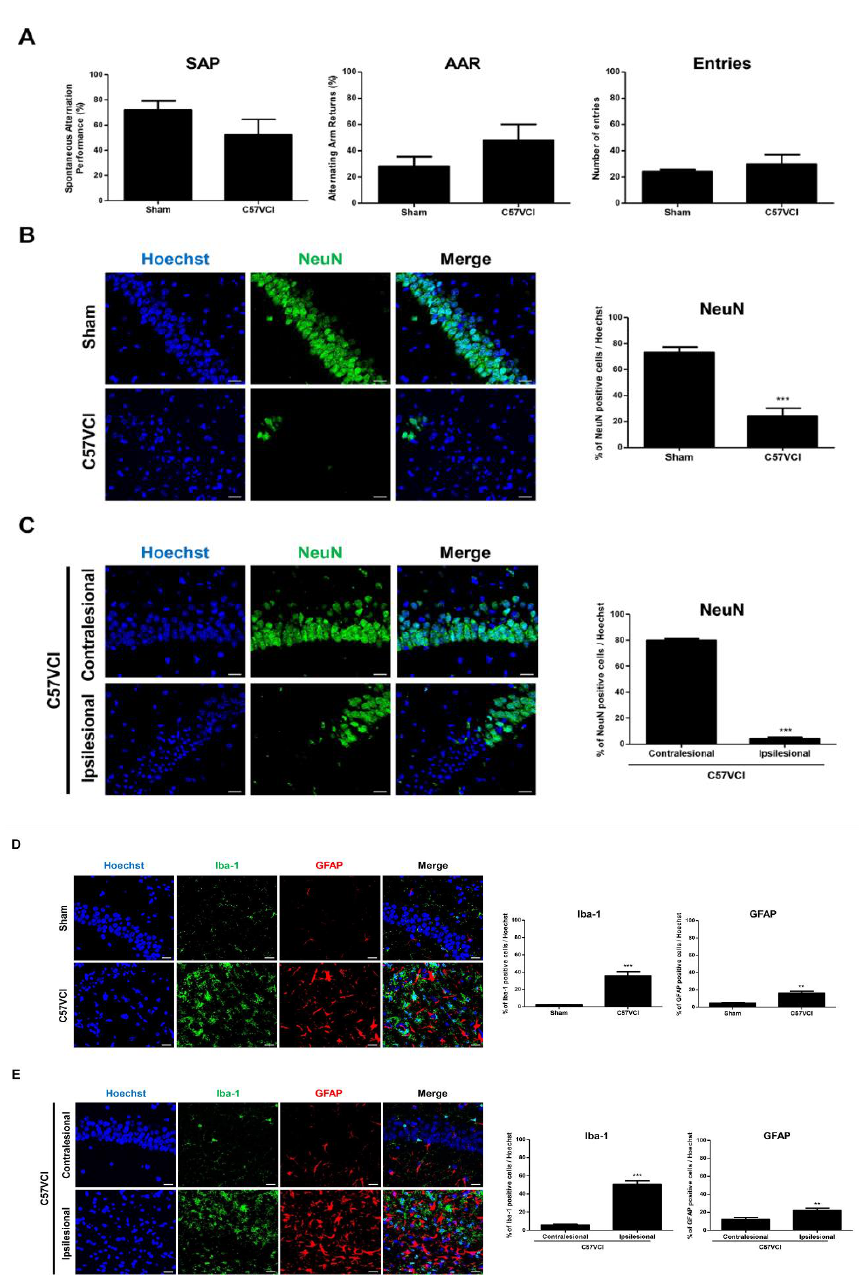
Figure 3. Changes in spatial working memory, neuronal density, and microglial/astrocyte activity following VCI surgery. ( A ) Changes in spatial working memory were assessed using the Y-maze on Day 32 after VCI was induced. Behavioral indices from left to right: spontaneous alternation performance (SAP), alternating arm returns (AAR), and number of entries. ( B , C ) NeuN immunostaining (green) of the hippocampus. ( B ) *** p < 0.001 vs. sham; mean ± S.E.M. ( C ) *** p < 0.001